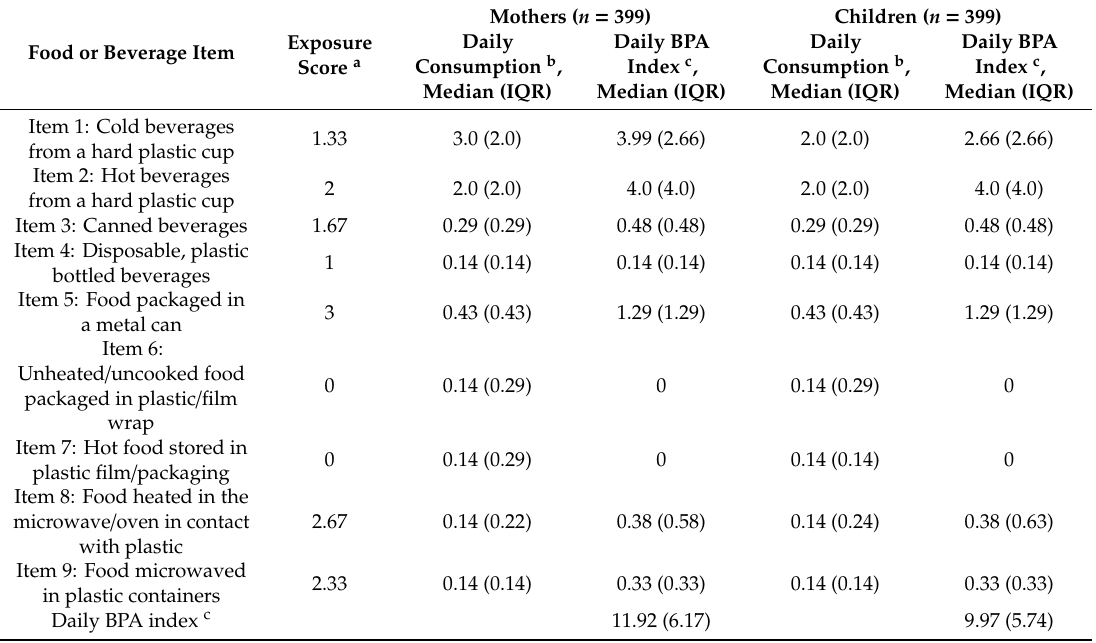
Table 2. Daily consumption patterns and bisphenol-A (BPA) exposure summary.